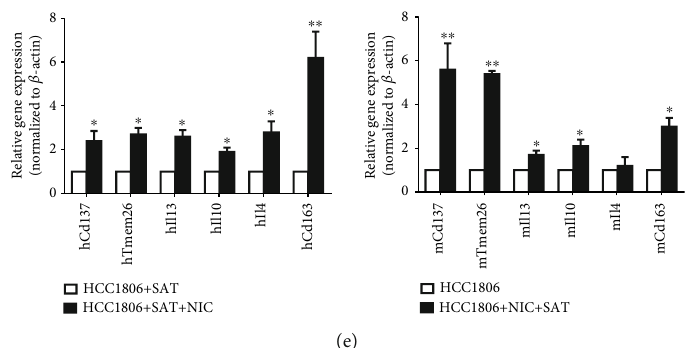
Figure 4: Quantitative gene expression analysis of HCC70 cells following ex vivo incubation with subcutaneous adipose tissue (SAT) from nude mice and ± NIC. HCC70 and HCC1806 breast cancer cells (5 × 10 6 cells) preincubated with SAT ± NIC (1 μ M) for 48h, following which (a) quantitative gene expression analysis of MCSCs was performed using human-speci fi c primer sets: HCC70 (left panel) and HCC1806 (right panel). (b) FACS analysis showing relative changes in OCT4 population in HCC70 cells incubated with SAT and ± NIC. Representative FACS analysis (left panel) and quantitative presentation ( n = 3 ) of OCT4 (right panel) is shown. (c) FACS analysis showing relative changes in SOX2 population in HCC1806 cells incubated with SAT and ± NIC. Representative FACS analysis (left panel) and quantitative presentation ( n = 3 ) of SOX2 (right panel) is shown. (d, e) Quantitative gene expression analysis of HCC70 or HCC1806 with SAT+ NIC for beige-adipocyte (CD137 and TMEM26), anti-in fl ammatory cytokines (IL13, 1L10, and IL4) and tissue-resident macrophages (CD163) using species-speci fi c primer sets. (d) HCC70 +SAT+ NIC: human (left panel) and mouse (right panel). (e) HCC1806+ SAT+NIC: human (left panel) and mouse (right panel). ∗ p ≤ 0 : 05 and ∗∗ p ≤ 0 : 01 ( n = 3